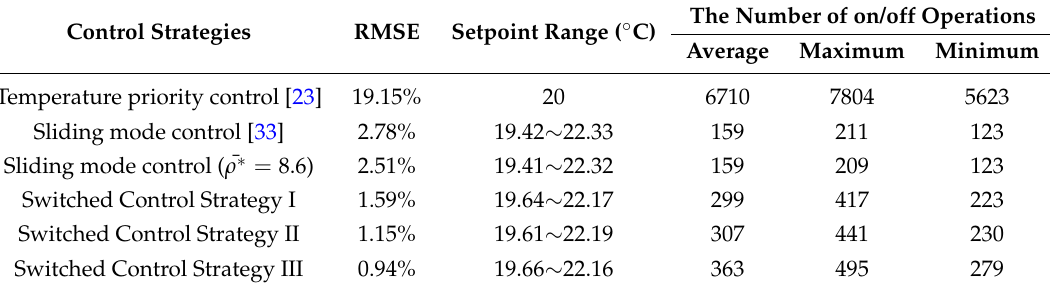
Table 4. Comparisons with the related